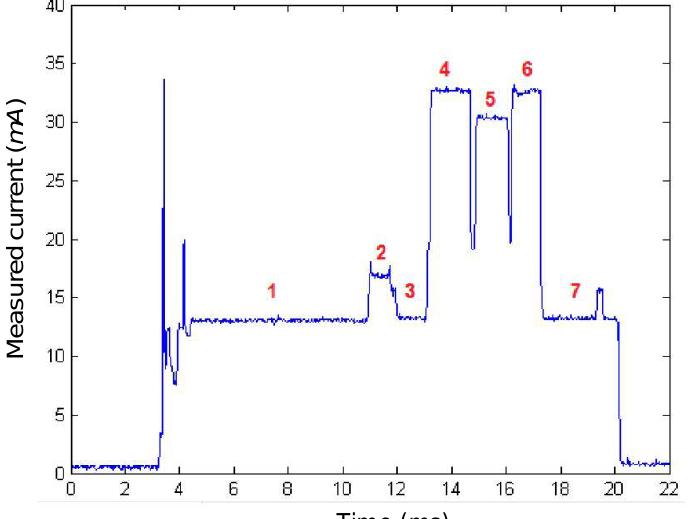
Figure 4. Measured supply current during the transmission of a data frame with sensed data to the